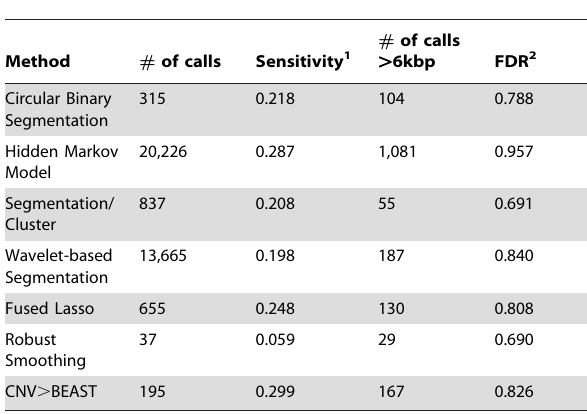
Table 3. Comparison of Sensitivity and